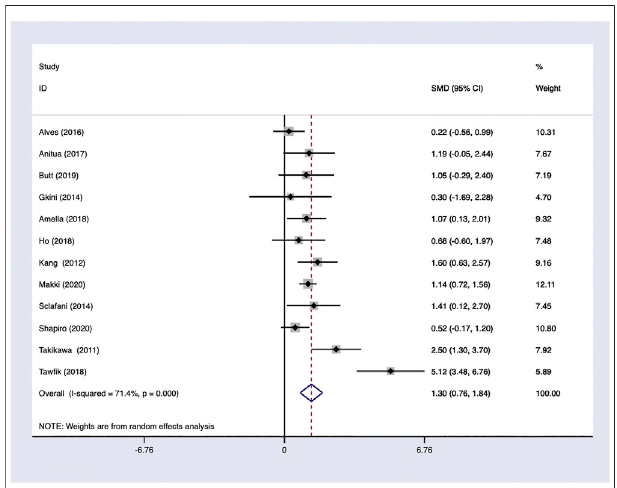
FIGURE 5 | PRP ef fi cacy compared to the